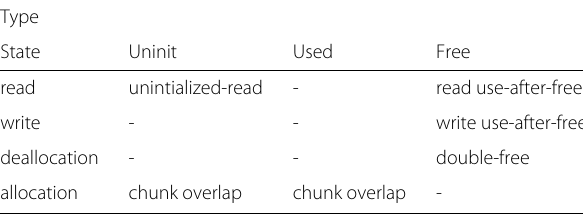
Table 1 Operation type error: the type of error generated by different types of operations accessing different memory states